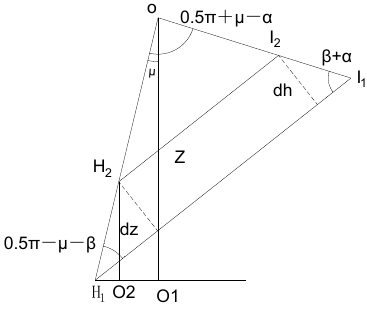
Figure 12. Mathematical model of material unit body.